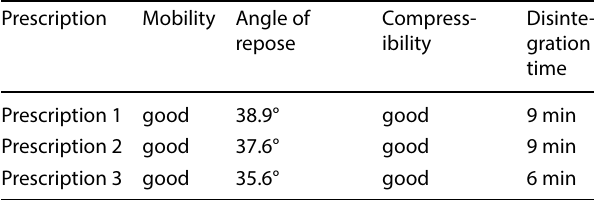
Table 3 Results of trial production of prescription